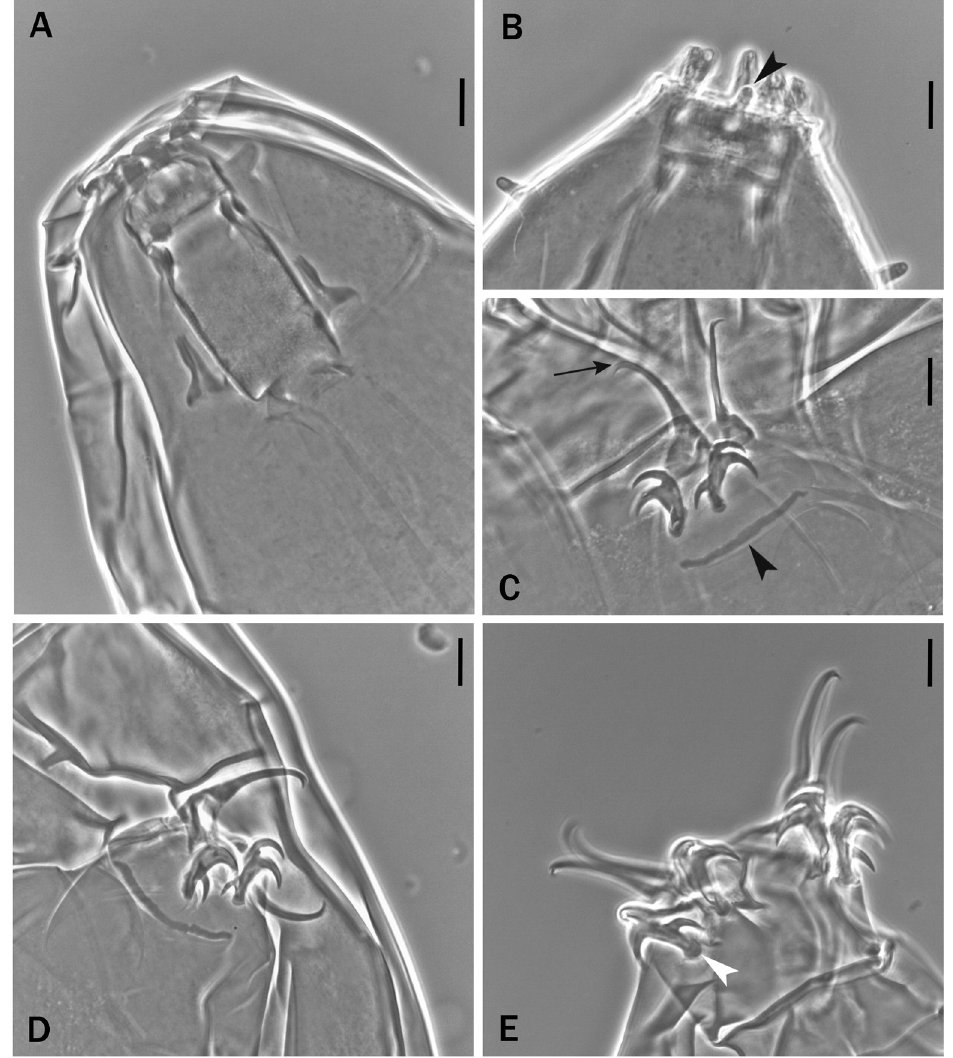
Fig. 21. Buccal tube, peribuccal papillae and claws of senior specimens of Milnesium quiranae sp. nov. A, C–E . Holotype, ♀ (slide No. MCNS Tar.000024-3). B . Paratype, ♀ (slide No. UNLPam 560-1). A . Buccal tube and related structures. B . Reduced medioventral peribuccal papilla (black arrowhead). C . Leg II with its claws; the black arrow indicates the accessory points, the black arrowhead indicates the leg cuticular bar. D . Leg III with its claws. E . Legs IV with their claws, the white arrowhead indicates a lunule. Scale bars = 10